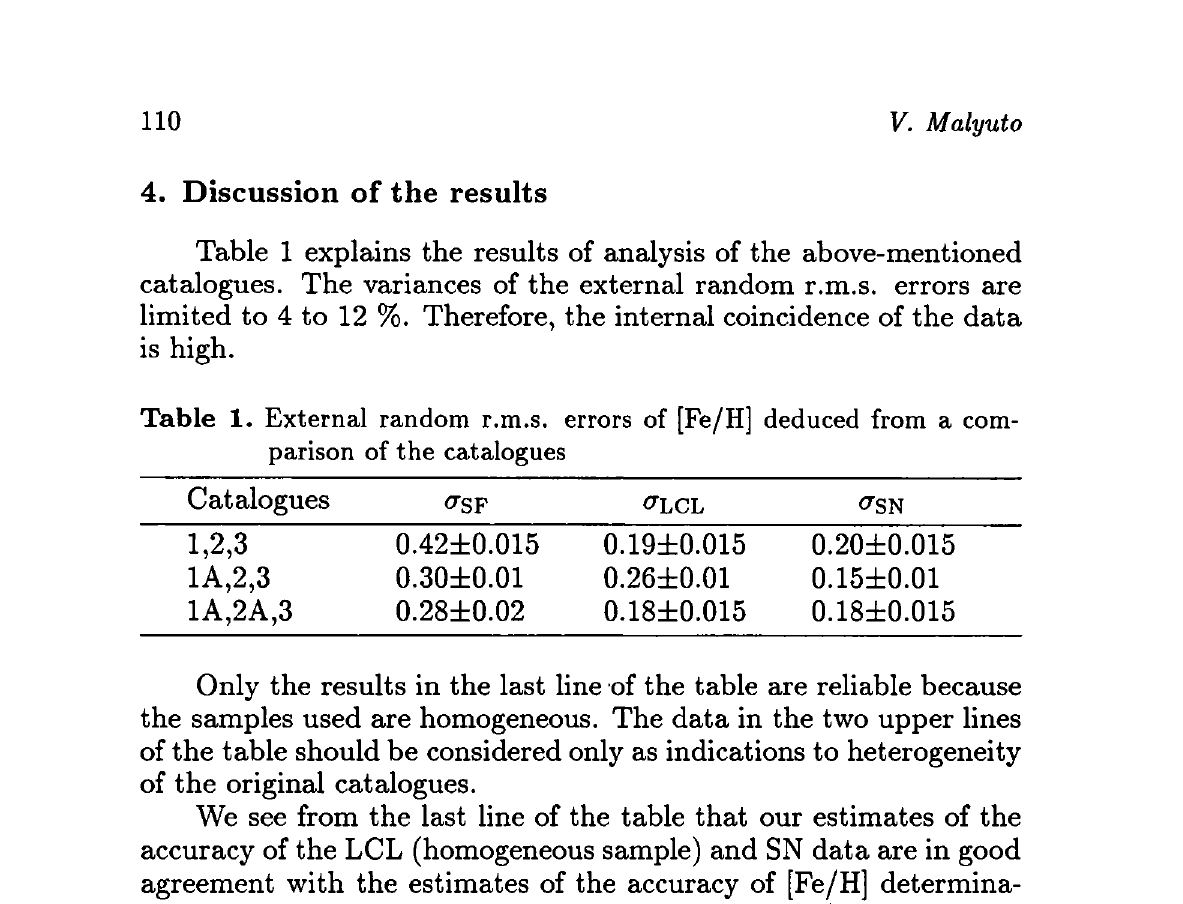
Table 1. External random r.m.s. errors of [Fe/H] deduced from a